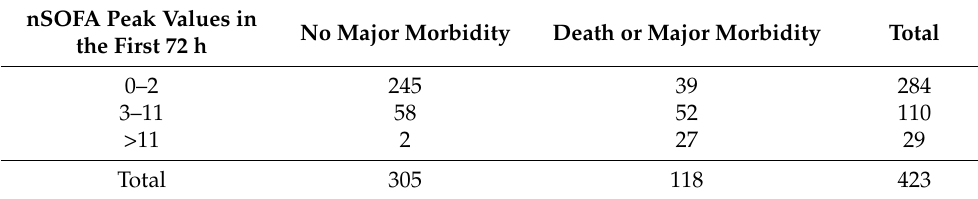
Abbreviations: nSOFA = Neonatal Sequential Organ Failure